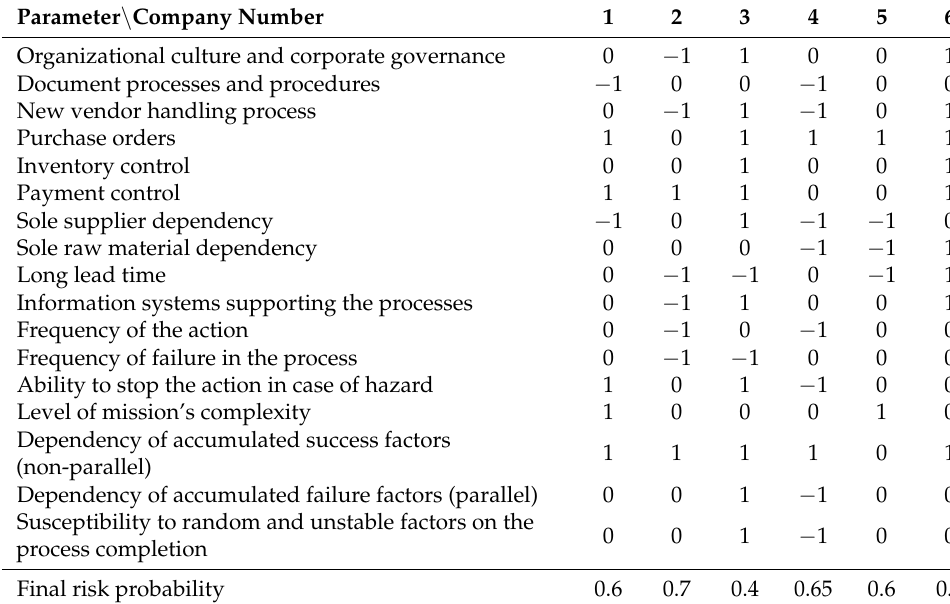
Table A1. Part of the dataset used to train the neural